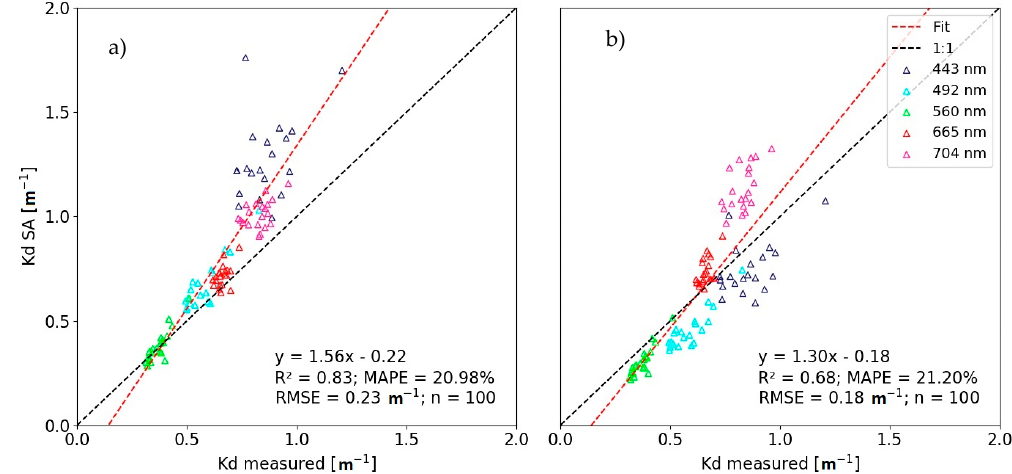
Figure 10. Global results for 𝐾 (cid:3031) (λ) derived from field 𝑅 (cid:3045)(cid:3046) (λ) measurements for: ( a ) QAA TM ; and, ( b ) QAAv6.